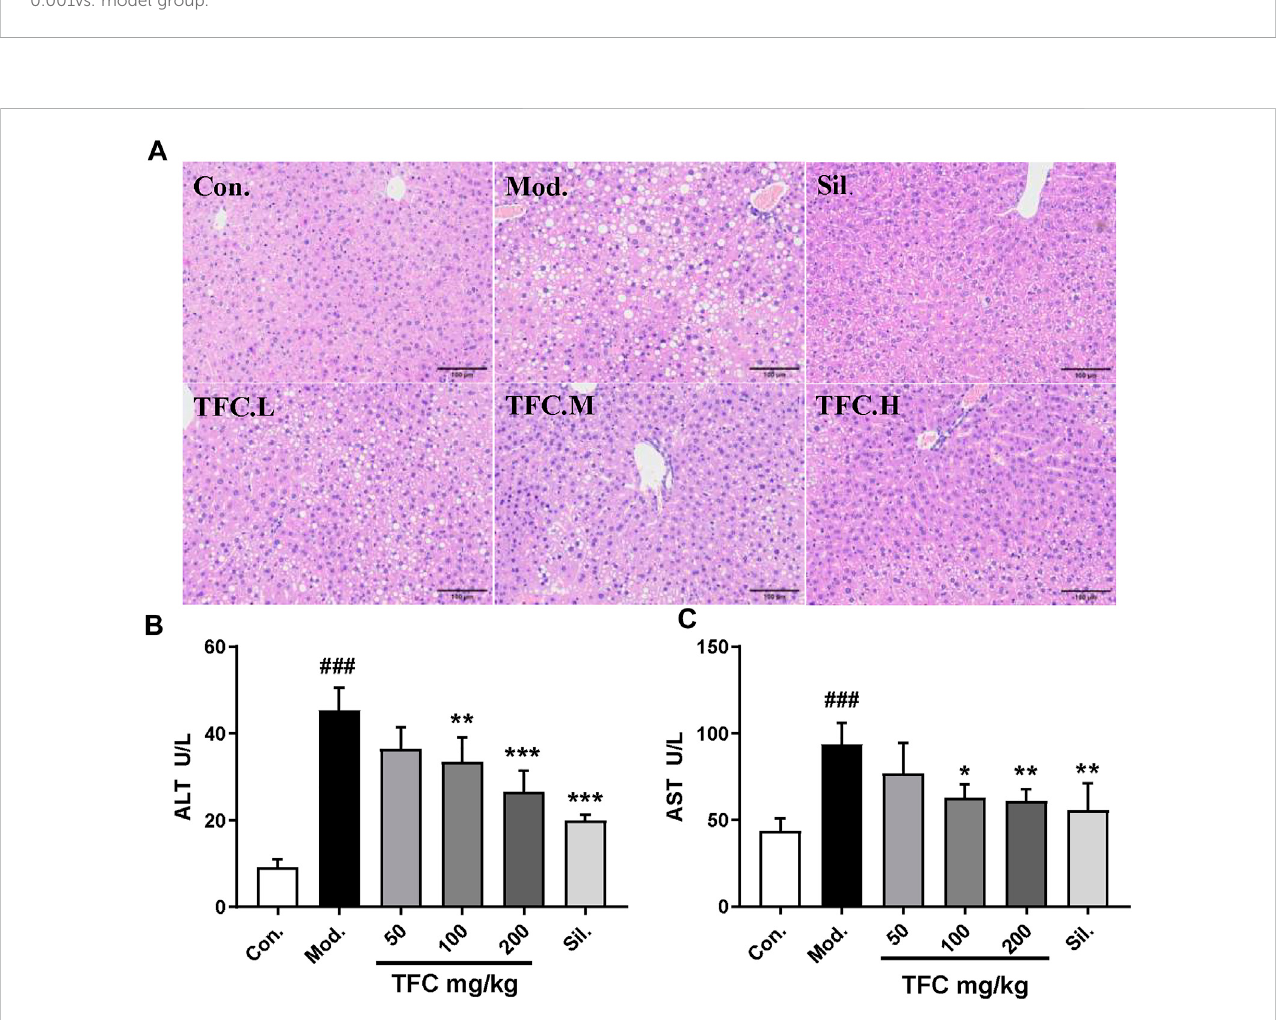
FIGURE 3 TFCalleviatesliverdamagecausedbyalcoholintake (A) HistologicalchangesofliversectionsmeasuredbyHEstainingat200×magni fi cati (B) serumALT (C) serum AST. Data are expressed as mean ± S.D. # p < 0.05, ## p < 0.01, ### p < 0.001 vs. control group; * p < 0.05, ** p < 0.01, *** p < 0.001vs. model